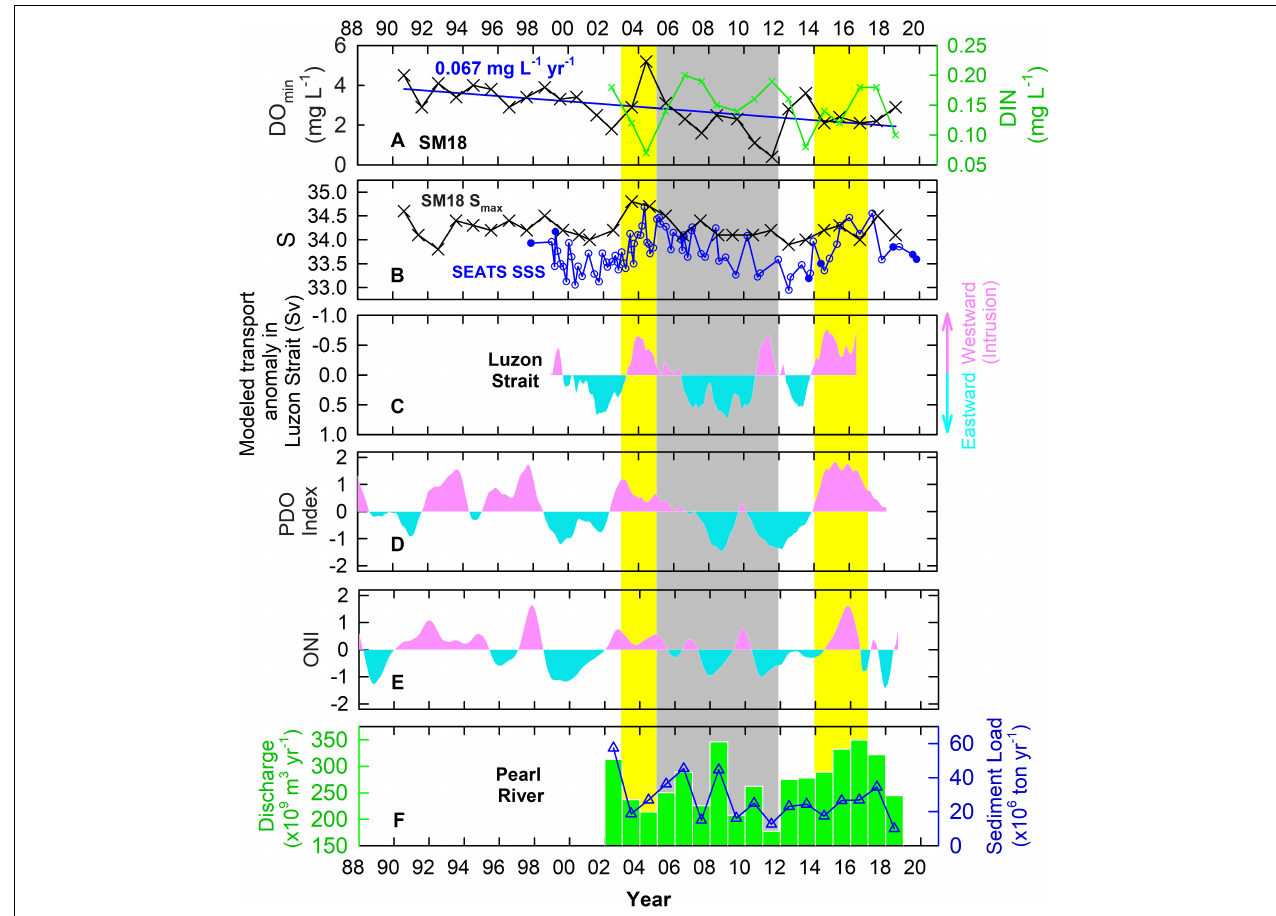
FIGURE 4 | Time series of (A) bottom water DO min (black cross) and DIN (green cross) at SM18, (B) bottom water S max at SM18 (black cross) and SSS at SEATS (taken from ODB: blue open circles, from this study: blue solid circles), (C) anomaly of water flux (0–300 m) through the Luzon Strait (vertical red and blue bands refer to positive and negative values, respectively), (D,E) deseasoned PDO index and ONI (vertical red and blue bands refer to positive and negative values, respectively), and (F) the annual average water discharge (green bar) and sediment load (blue open triangle) of the Pearl